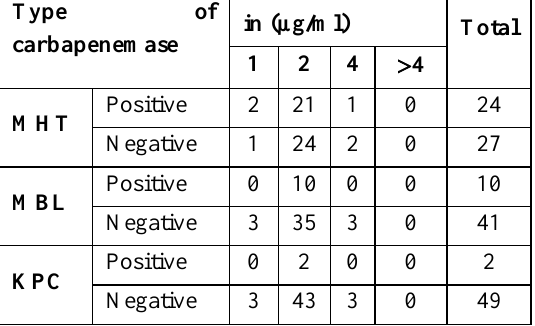
Table 11. Comparison of disc diffusion and MIC for